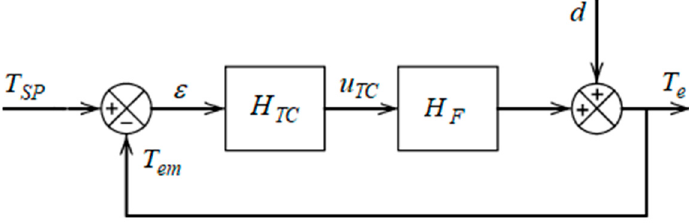
Figure 4. The conventional control block diagram.